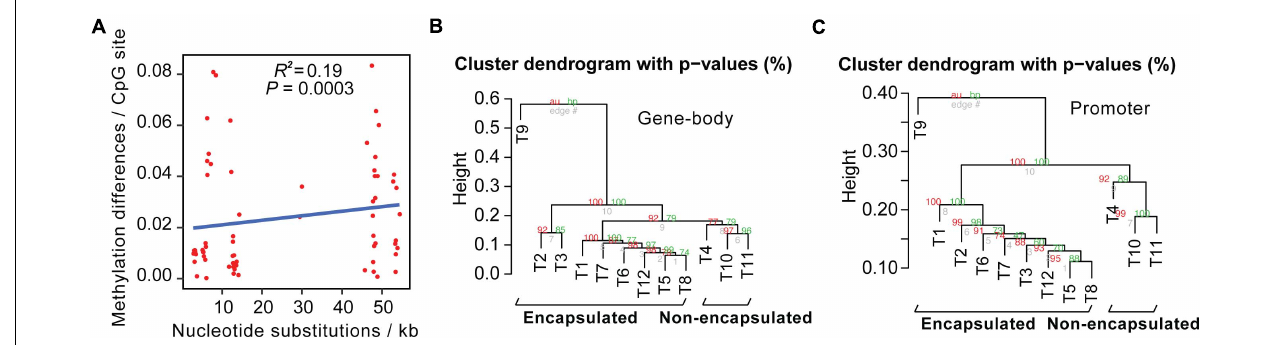
FIGURE 2 | Interspecies methylome variation could reflect evolutionary history across Trichinella spp. (A) Methylation changes correlate with sequence differences. The x -axis represents the number of nucleotide substitutions between the two species per kb. The y -axis represents methylation differences of interspecies conservative methylated CpG sites. (B,C) Hierarchical clustering analysis based on DNA methylation levels of the gene-bodies (B) or promoters (C) of the 2708 SCOs in Ad